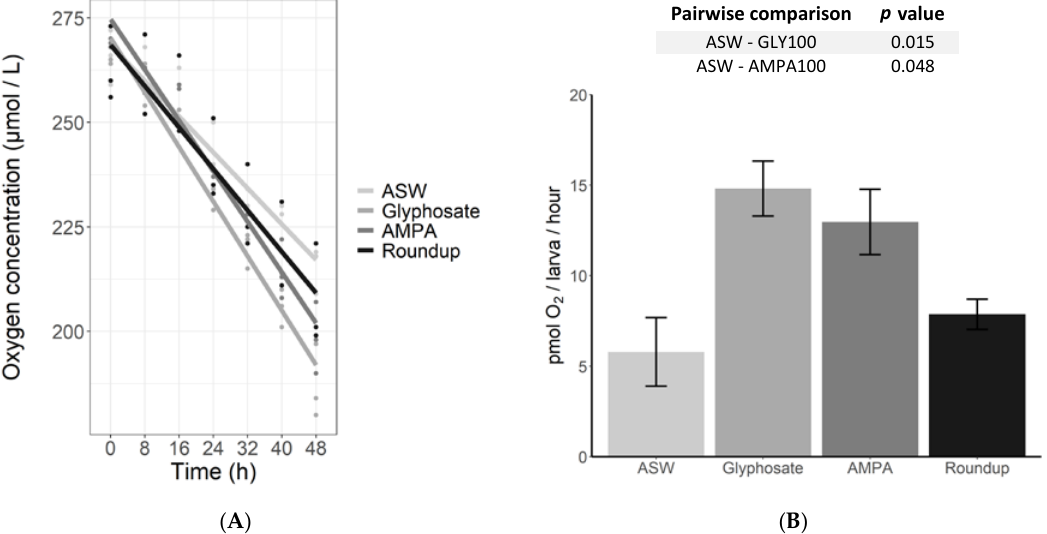
Figure 7. ( A ) Oxygen concentration throughout the larval exposure (48 h) in the four experimental conditions tested: control (ASW) and 100 µ g / L of the three contaminants, glyphosate (GLY), AMPA and Roundup (RU). Regression lines are shown. ( B ) Oxygen consumption (pmol O 2 / larva / hour) in larvae exposed to the four experimental conditions for 48 h. Values are means ± s.e., n = 3. Statistically significant pairwise comparisons are reported in the table above the